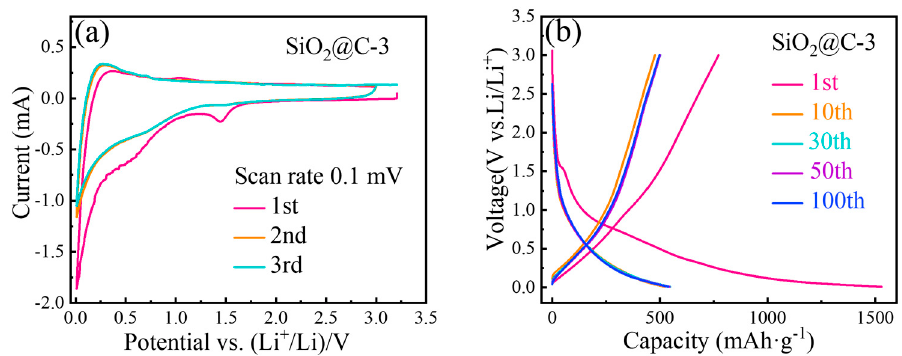
Figure 6. SiO 2 @C − 3 composites: ( a ) CV curves, ( b ) charge and discharge performances. Figure 6. SiO 2 @C-3 composites: ( a ) CV curves, ( b ) charge and discharge performances. Voltage profiles of SiO 2 @C-3 composites at a current density of 1 A g − 1 are given